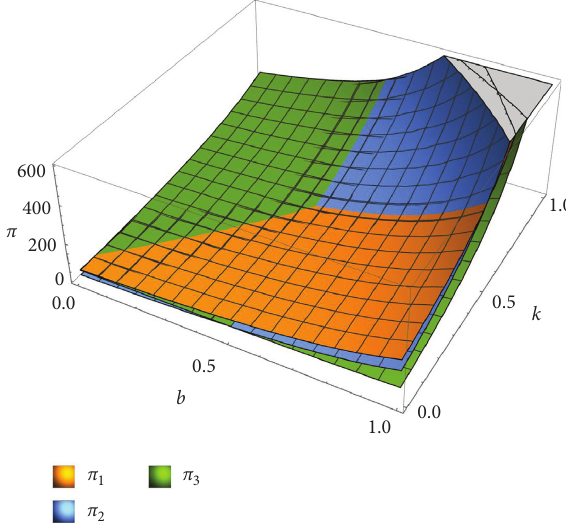
Figure 5: The influence of b and d on corporate profits when k �